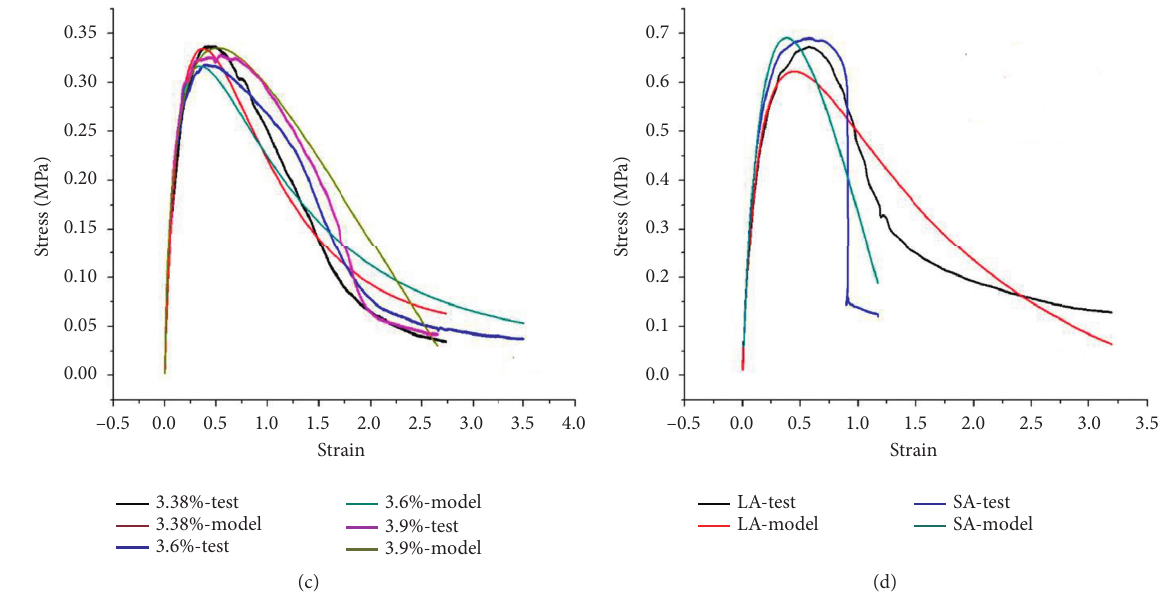
Figure 5: Comparisons between the test and model corresponding to the (a) loading rate, (b) temperature, (c) asphalt aggregate ratio, and (d) degree of